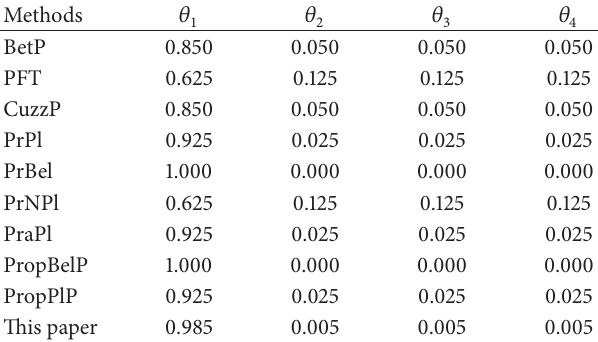
Table 3: The comparisons of different methods.